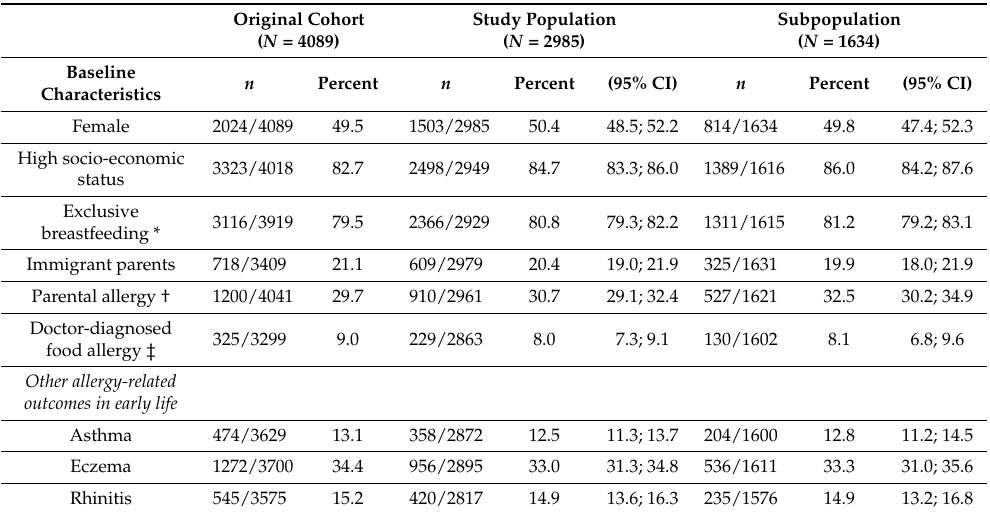
Table 1. Distribution of baseline characteristics and other allergy-related outcomes in early life of the entire cohort and the study